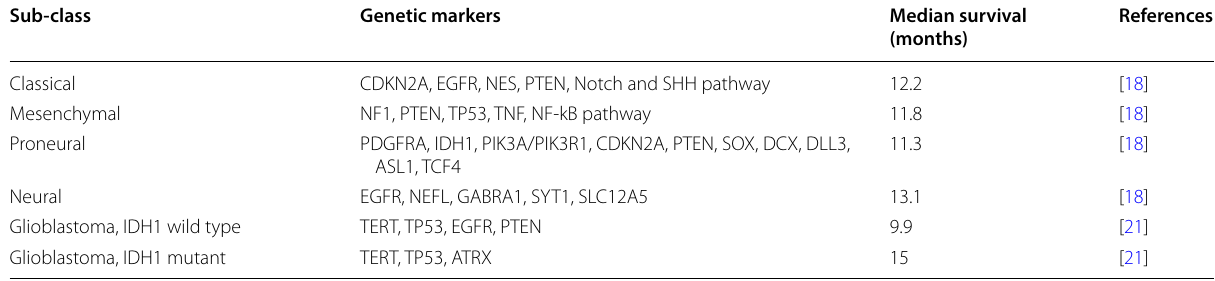
Table 1 Glioblastoma multiforme classification by The Cancer Genome Atlas and World Health Organization